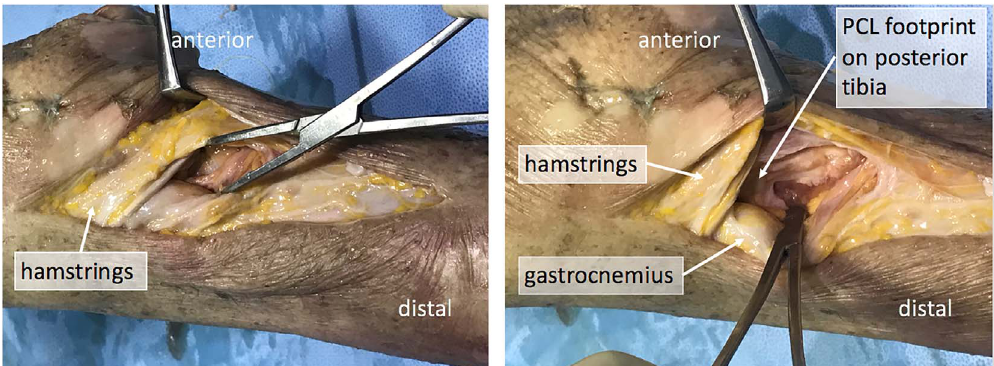
Figure 3. Medial Lobenhoffer approach in a left cadaveric knee. Left : the haemostat shows access to the posterior part of the knee, inferior to the attachments of the hamstrings. Right : the gastrocnemius muscle is re fl ected posteriorly to give access to the posterior capsule and posterior cruciate ligament. Note the haemostat is spreading fi bres of the popliteus muscle. Leaving the pes intact and working above and below the pes in knee fl exion allows for safe access to the back of the